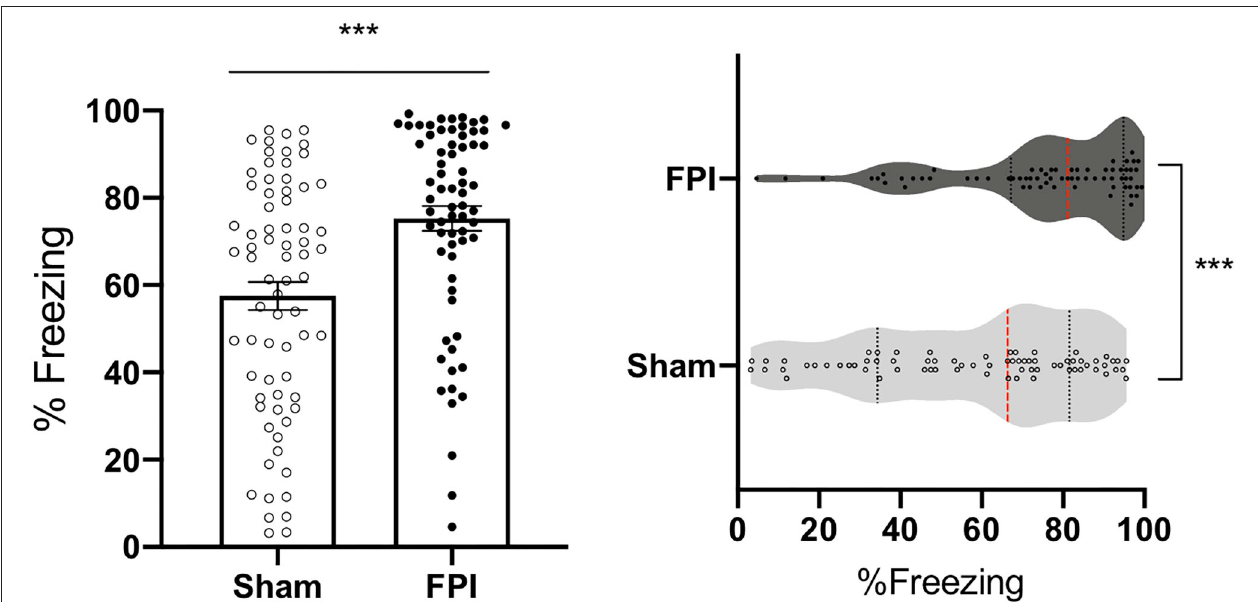
FIGURE 7 | FPI enhanced context fear across all experiments. Across the three experiments, FPI groups showed significantly greater freezing in the conditioning context compared to sham (first 8min), regardless of sex and shock intensity. Data from experiment 1 include recent context test only for consistency with the other experiments. Group totals: n = 71/Sham; n = 69/FPI. (Left) Data are represented as mean ± SEM; *** p < 0.001. (Right) Violin plots representing the distribution of the data for context fear, red dotted line represents the median and black dotted lines are quartile ranges;*** p <